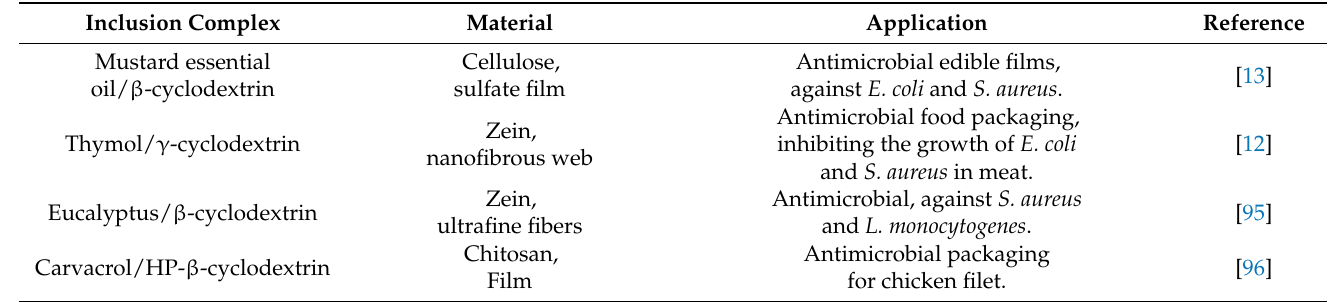
Table 4. Inclusion complexes with cyclodextrin and essential oils used in active food packaging